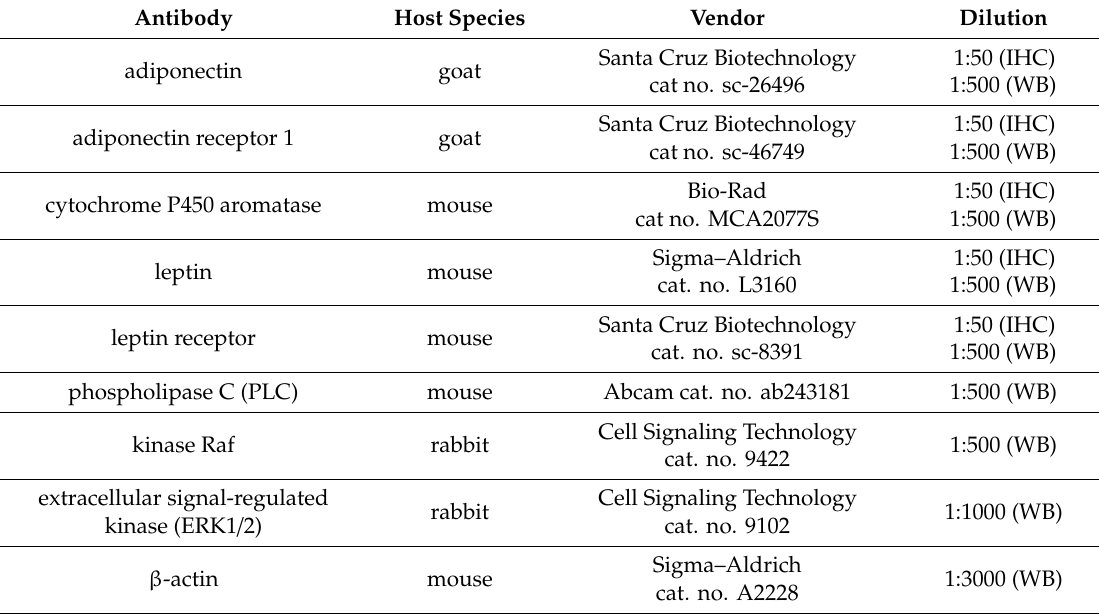
Table 1. Primary antibodies used for Western blot and